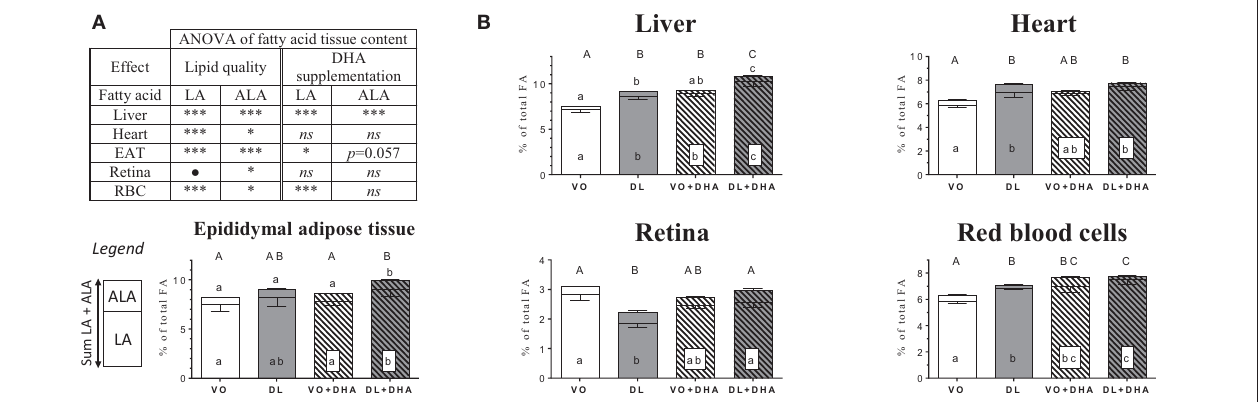
FIGURE 5 | (A) Overall lipid quality (LQ) effect and DHA supplementation (S) effect of linoleic acid (LA) and α -linolenic acid (ALA) proportions in brain, retina, heart, liver and red blood cells (RBC) of rats fed the vegetable oil blend diet (VO) or the vegetable oil and dairy lipid blend diet (DL), not supplemented or supplemented with 0.5%